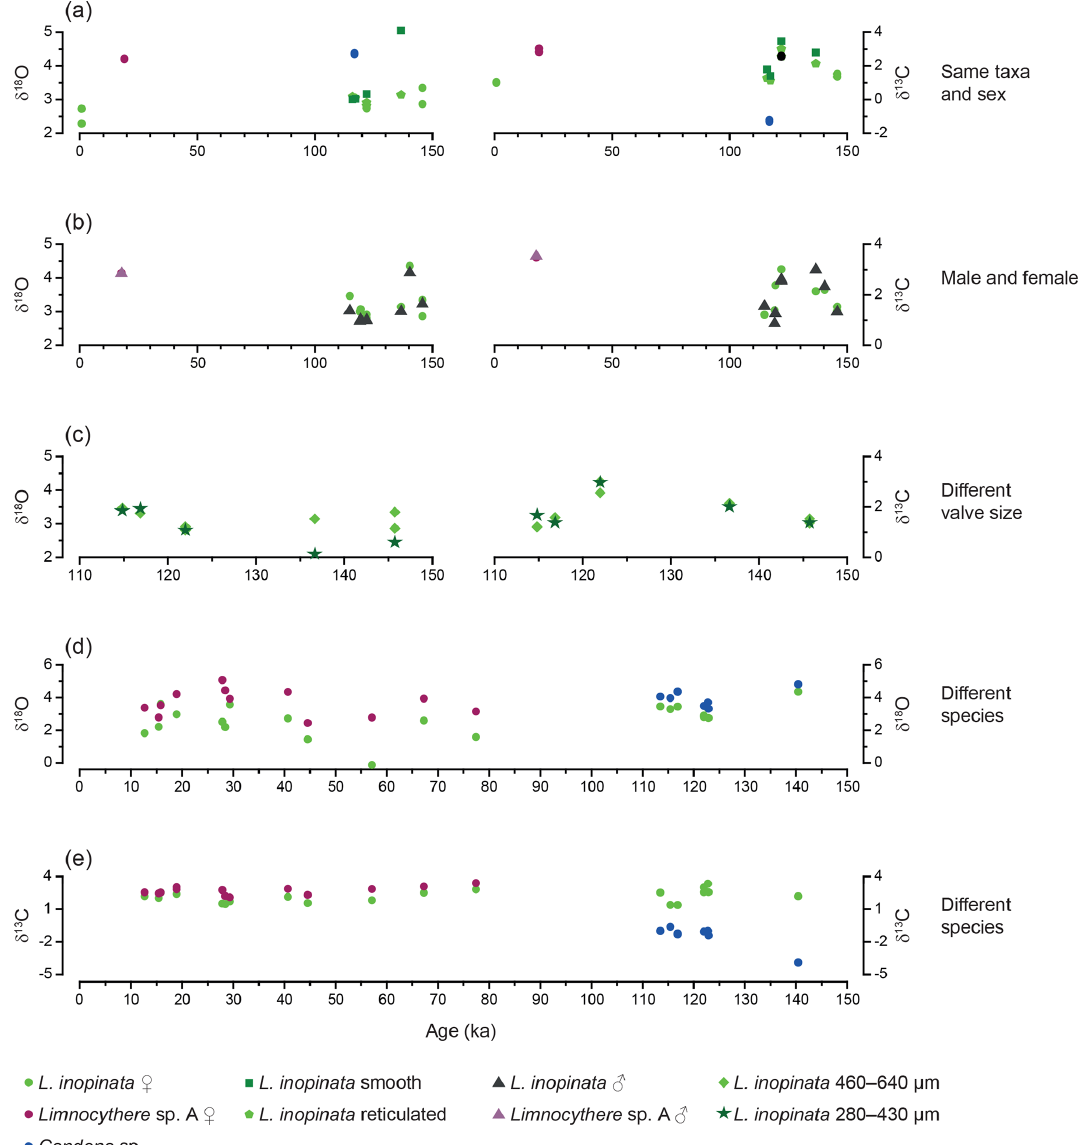
Figure 5. Isotopic variability between ostracod measurements from the same stratigraphic horizon against age. (a) Variability between valves of the same taxa and sex. (b) Variability between L. inopinata and Limnocythere sp. A female and male valves. (c) Variability between L. inopinata of different valve size. (d) δ 18 O variability between L. inopinata and Limnocythere sp. A and L. inopinata and Candona sp. (e) δ 13 C variability between L. inopinata and Limnocythere sp. A and L. inopinata and Candona sp. Limnocythere sp. A and Candona sp. could not be compared, as they never occur in the same stratigraphic